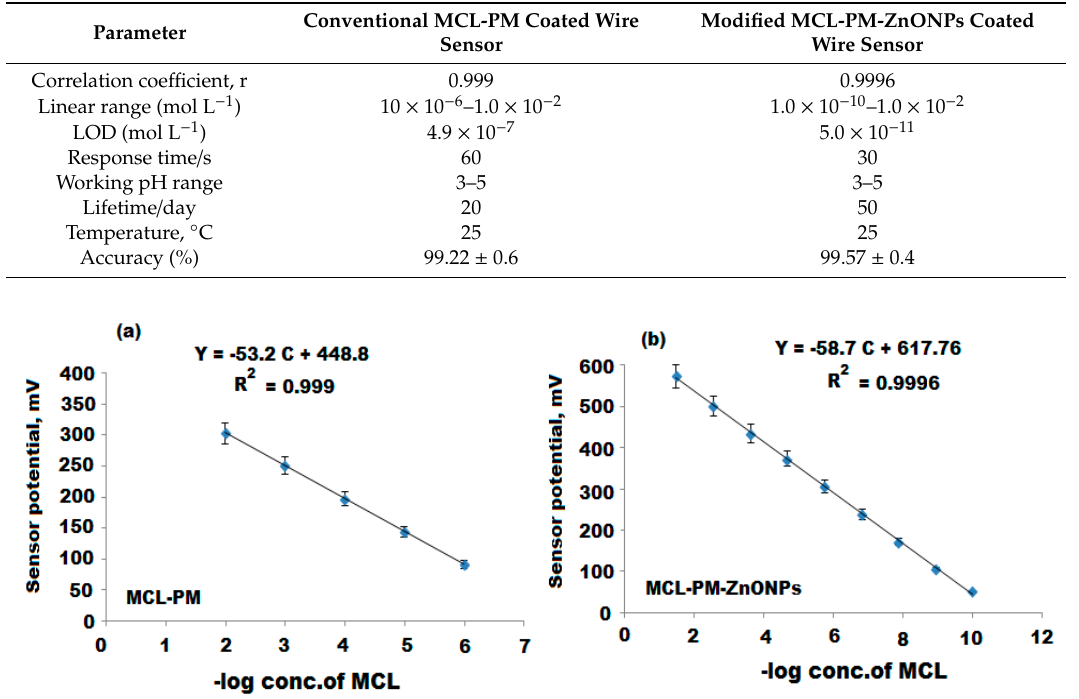
Figure 8. Calibration graphs of the constructed ( a ) Conventional minocycline–phosphomolybdate (MCL-PM) and ( b ) Modified MCL-PM-ZnONPs-coated wire sensors. Table 1. Characteristic responses of conventional coated wire MCL-PM and modified MCL-PM- ZnONPs-coated wire sensors.